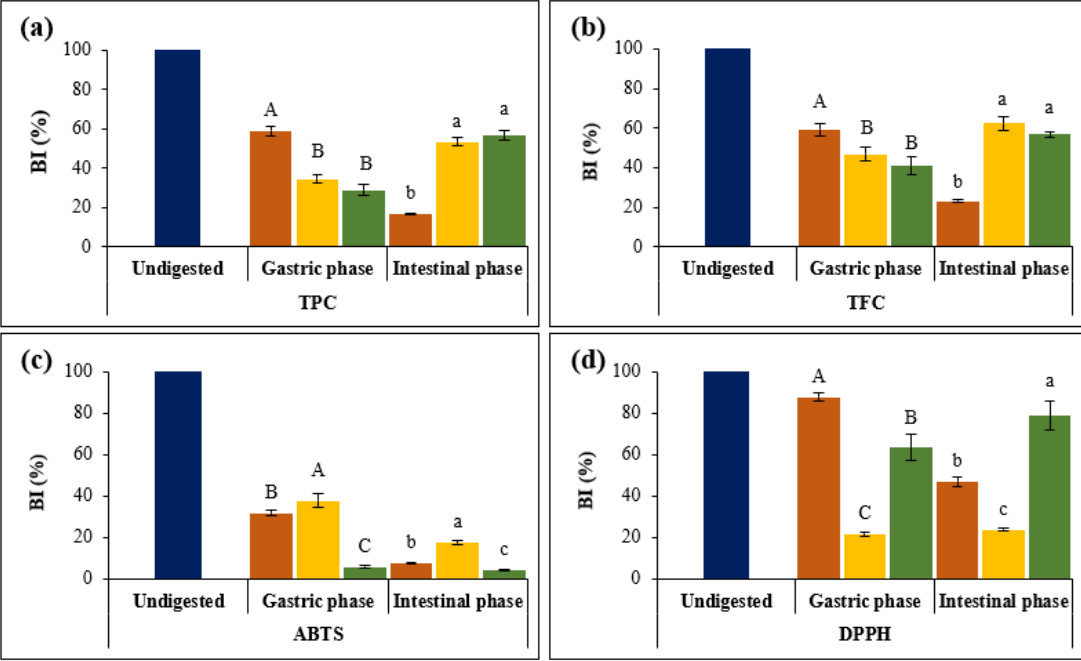
Figure 8. Bioaccessibility index (BI) after in vitro digestion: ( a ) total phenolic content (TPC); ( b ) total flavonoid content (TFC); ( c ) ABTS; ( d ) DPPH. Uppercase letters indicate significant differences ( p ≤ 0.05) between unencapsulated extract or microencapsulated extract after gastric phase. Lowercase letters indicate significant differences ( p ≤ 0.05) between unencapsulated extract or microencapsulated extract after the intestinal phase.